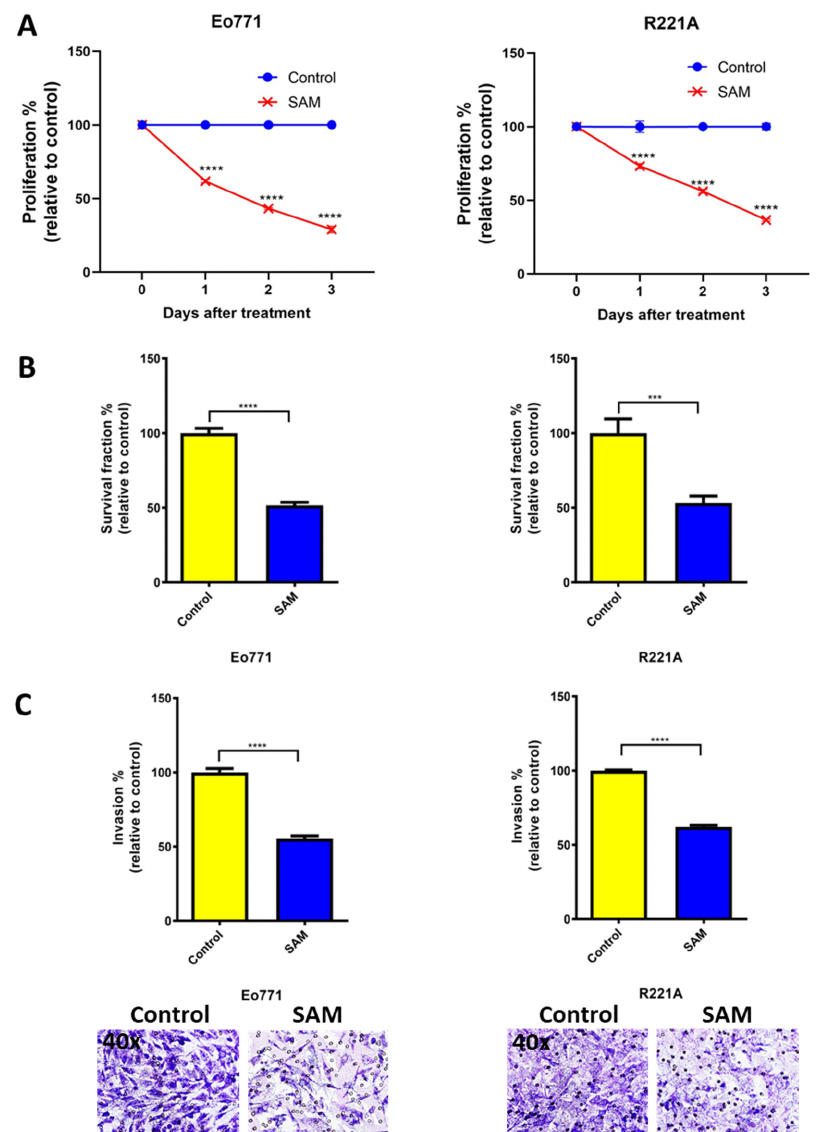
Figure 1. Effect of SAM on proliferation, colony-formation (survival), and invasion of luminal B BCa cell lines. ( A ) Percentage proliferation ( ± SEM) relative to control at 1, 2, and 3 days after SAM treatment. Briefly, Eo771 (4 × 10 4 ) and R221A (1 × 10 4 ) cells were seeded in 6-well plates, treatment with SAM (200 µ M) started 2 days after seeding, and they were treated every day for 3 days. Cells were trypsinized and counted 1, 2, and 3 days after SAM treatment. ( B ) Percentage survival fraction ( ± SEM) relative to control obtained from soft agar colony formation assay. The colony formation assay was performed after the regular proliferation assay, and then the treated Eo771 (5 × 10 3 ) and R221A (5 × 10 3 ) cells were plated. Media was replenished every 4–5 days and colonies were counted after 3 weeks. ( C ) Invasion assay was performed after performing the regular proliferation assay and then incubating the treated cells (1.25 × 10 5 ) for 18 h in two-compartment Boyden chambers coated with Matrigel. Top: Percentage invasion ( ± SEM) relative to control. Bottom: Representative images (lens, 40 × ; magnification, 400 × ) of invaded cells. Results are the mean of at least three independent experiments. Statistical significance was determined by ( A ) two-way ANOVA and ( B , C ) T-test in GraphPad prism. Significance values are represented by asterisks (*** p < 0.001; **** p <